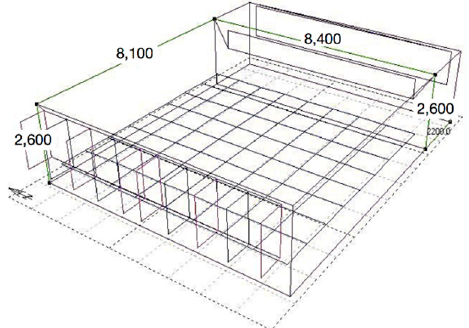
Figure 2. Model with analysis and size. Table 1. Input data for